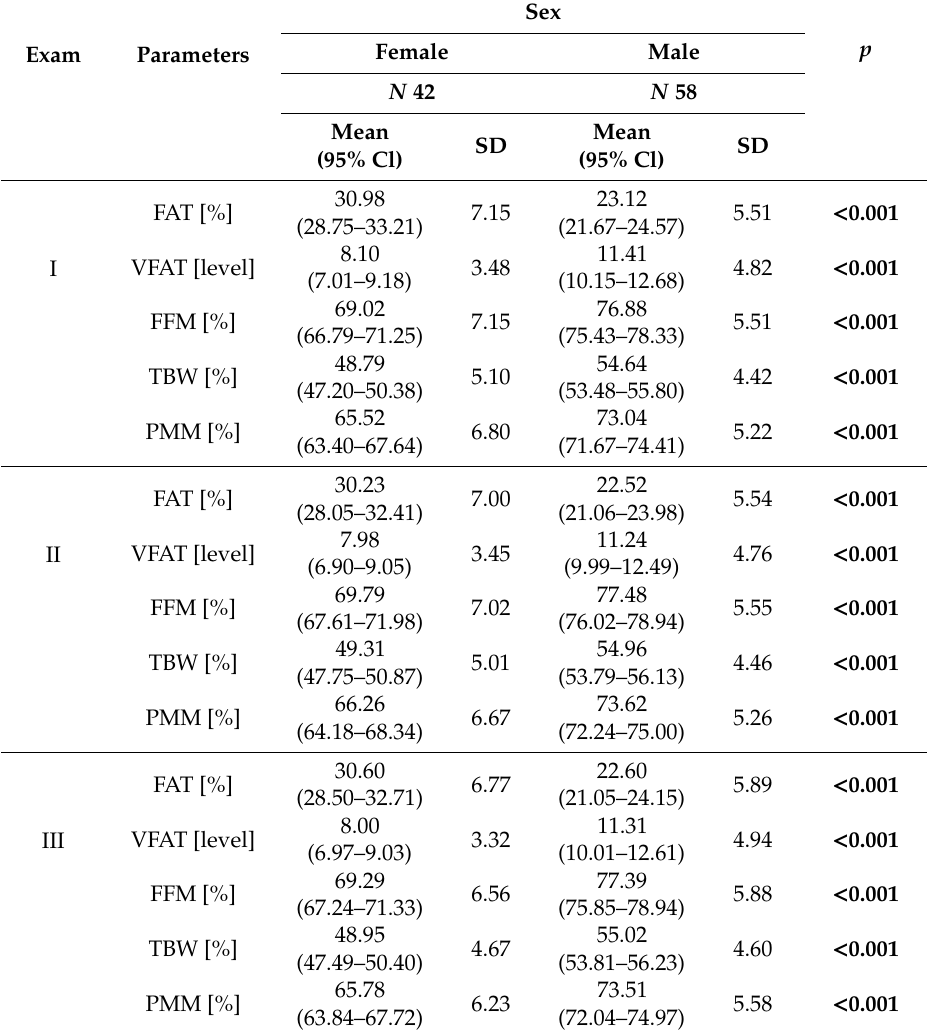
Table 1. Body mass components versus subjects’ sex.